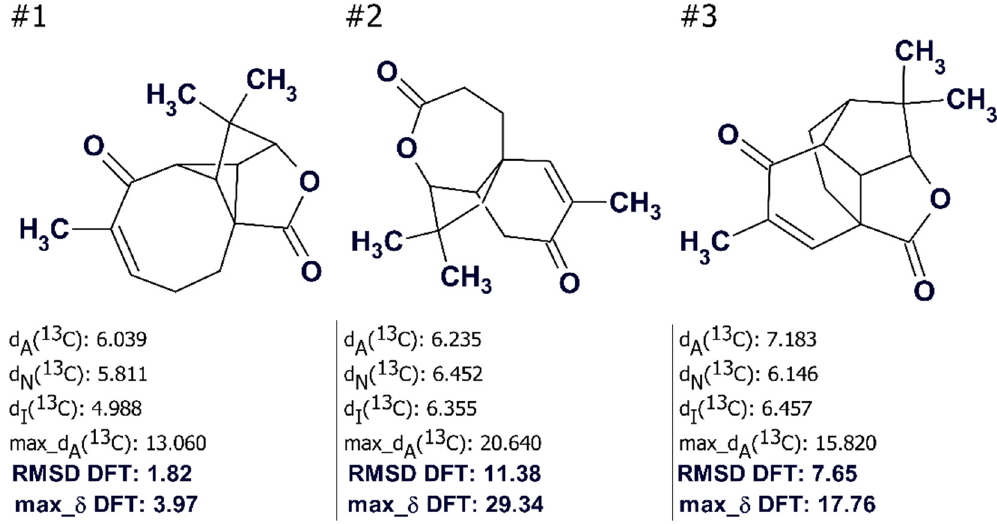
Figure 21. Ranked output file for aquatolide produced by ACD/SE. RMSD DFT is based on the difference between the experimental and DFT calculated 13 C chemical shifts, and the max_ δ DFT is the maximum deviation the between experimental and DFT calculated 13 C chemical shifts.